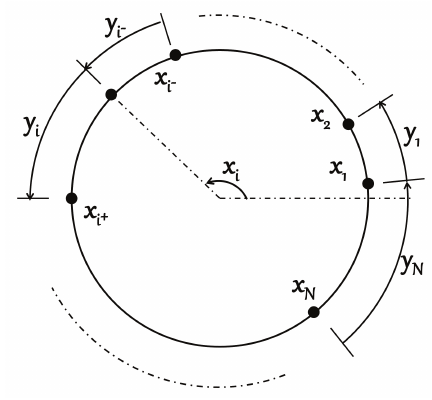
Figure 1. N agents distribute on a